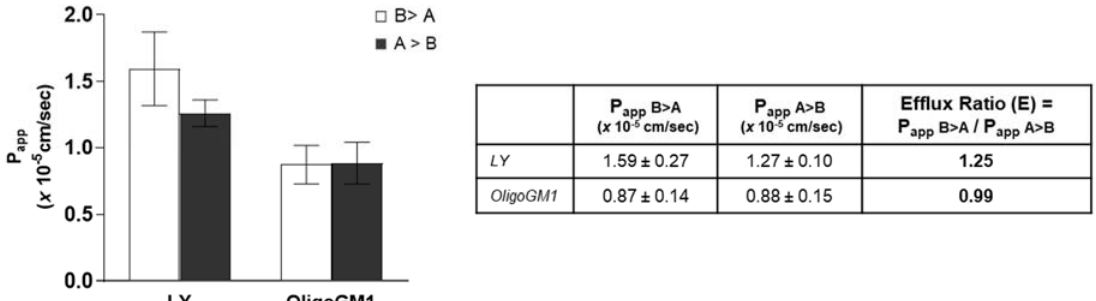
Figure 7. Bidirectional transport experiment across hBLECs. Left: Papp of LY and OligoGM1. For the inverse transport experiment (B > A), 50 μ M LY or 50 μ M plus 1 × 10 6 dpm OligoGM1 was added to the basolateral compartment and the related quantity of OligoGM1 found in the apical compartment was measured after 60 min ( □ ). For the direct transport experiment (A > B), 50 μ M LY or 50 μ M plus 1 × 10 6 dpm OligoGM1 was added to the apical compartment and the related quantity of OligoGM1 found in the basolateral compartment was measured after 60 min ( ■ ). Right: Permeability efflux ratio (E) values for 50 µ M LY and OligoGM1. Results are mean ± SEM from 4 independent experiments ( n = 4), performed by examining a minimum of 3 wells for each